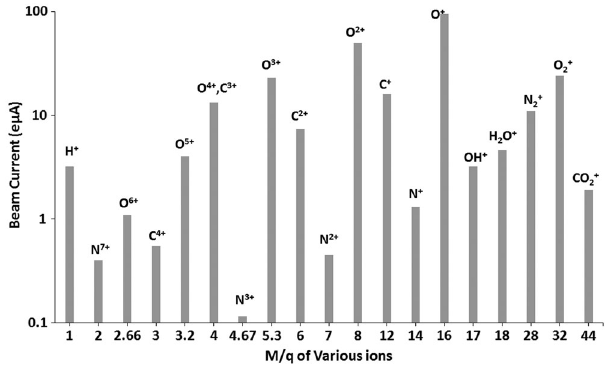
ffiffiffiffiffiffiffiffiffiffiffiffiffi p E ð eV Þ =B ð kG Þ . In